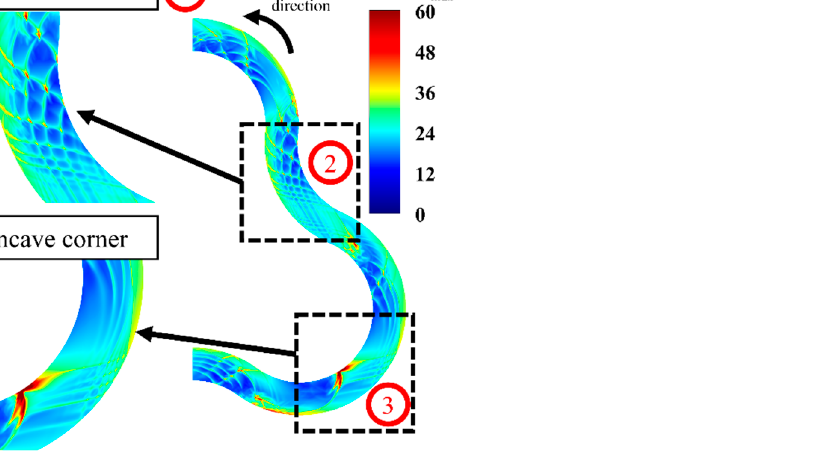
Figure 11. Local maximum pressure traces showing detonation cell structures from numerical analysis of the tri-arc RDE.